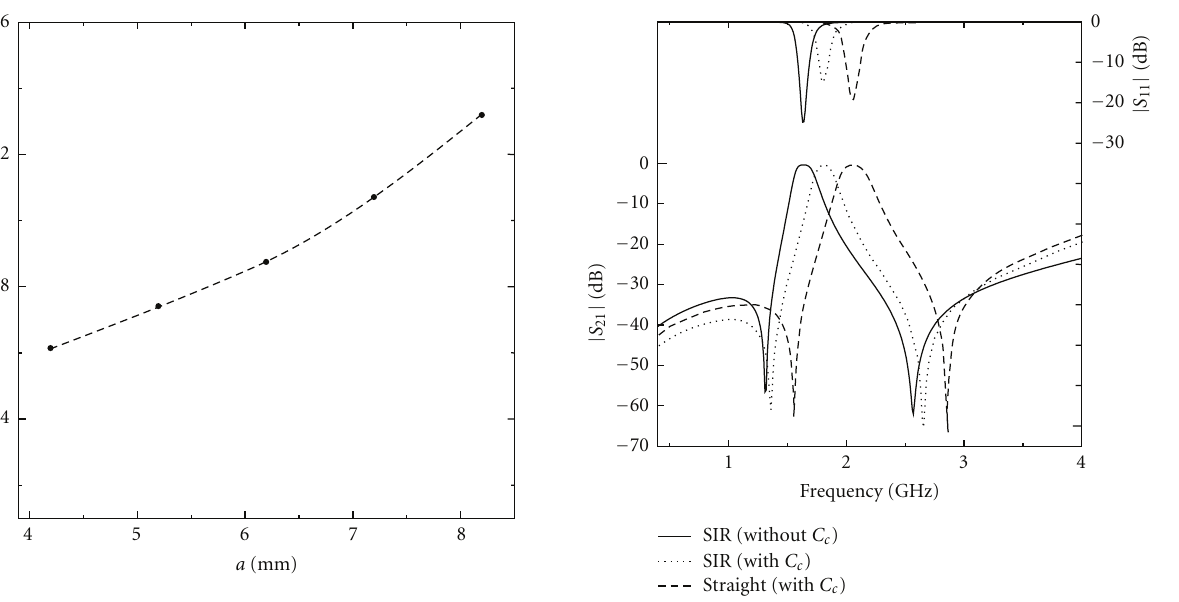
Figure 12: Frequency characteristics of scattering parameters (solid line: s 1 = 0 . 1mm and s 2 = 0 . 2 mm (without C c ), dotted line: s 1 = 0 . 4mm and s 2 = 0 . 9 mm (with C c ), and dashed line: a = 5 . 2 mm and d = 1 . 0mm (Figure 2)).